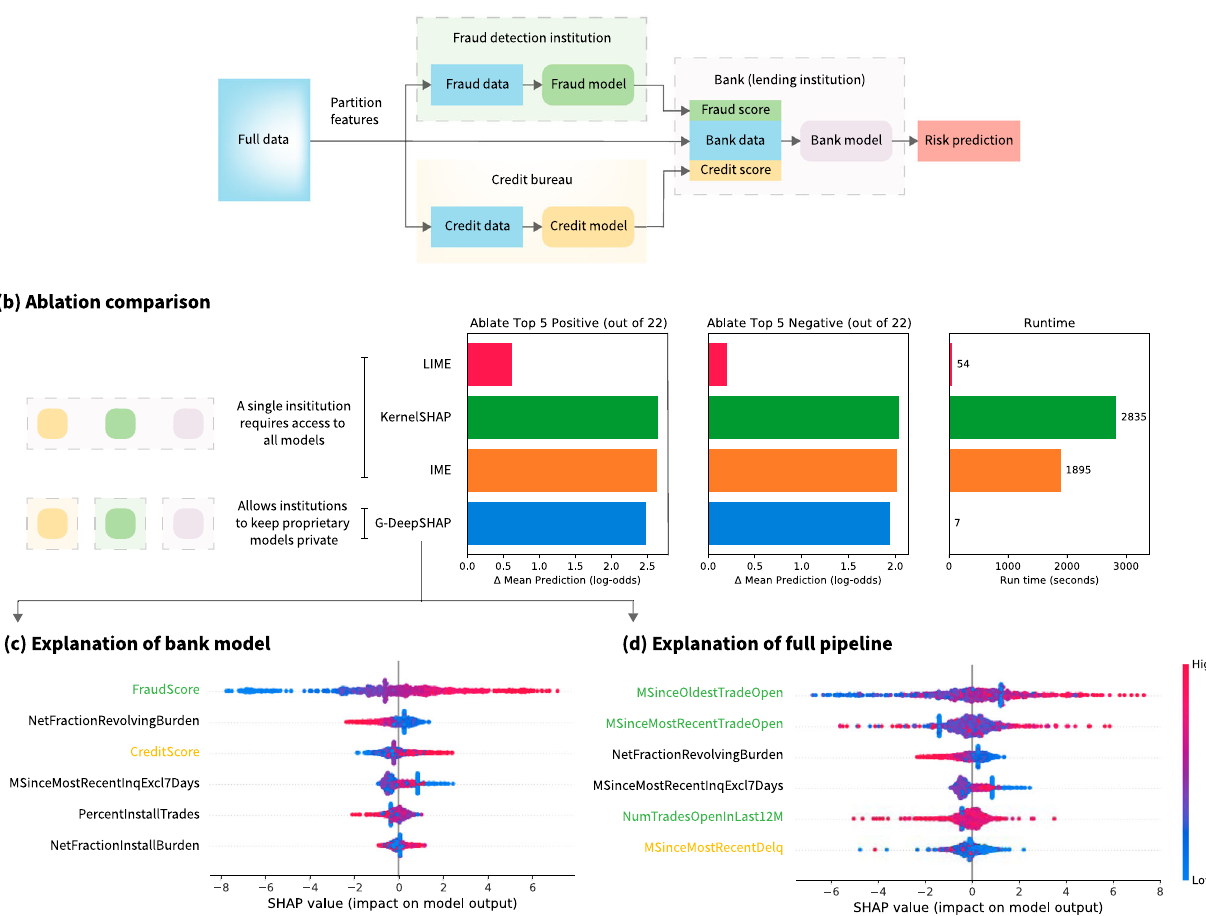
Fig. 7 Explaining a stacked generalization pipeline of models for the HELOC data set (details in Supplementary Methods Section 1.1.7). a A simulated model pipeline in the fi nancial services industry. We partition the original set of features into fraud, credit, and bank features. We train a model to predict risk using fraud data and a model to predict risk using credit data. Then, we use the outputs of the fraud and credit models as scores alongside additional bank features to predict the fi nal customer risk. b Ablation tests (ablating top fi ve positive/negative features out of a total 22 features) comparing model- agnostic approaches (LIME, KernelSHAP, IME), which require access to all models in the pipeline, and G-DeepSHAP, which allows institutions to keep their proprietary models private. c Summary plot of the top six features the bank model uses to predict risk (TreeSHAP). d Summary plot of the top six features the entire pipeline uses to explain risk (G-DeepSHAP). The green features originate from the fraud data and the yellow features from the credit data. We explain 1000 randomly sampled explicands using 100 randomly sampled baselines for all attribution methods. Note that ( c ) and ( d ) show summary plots (Supplementary Methods Section